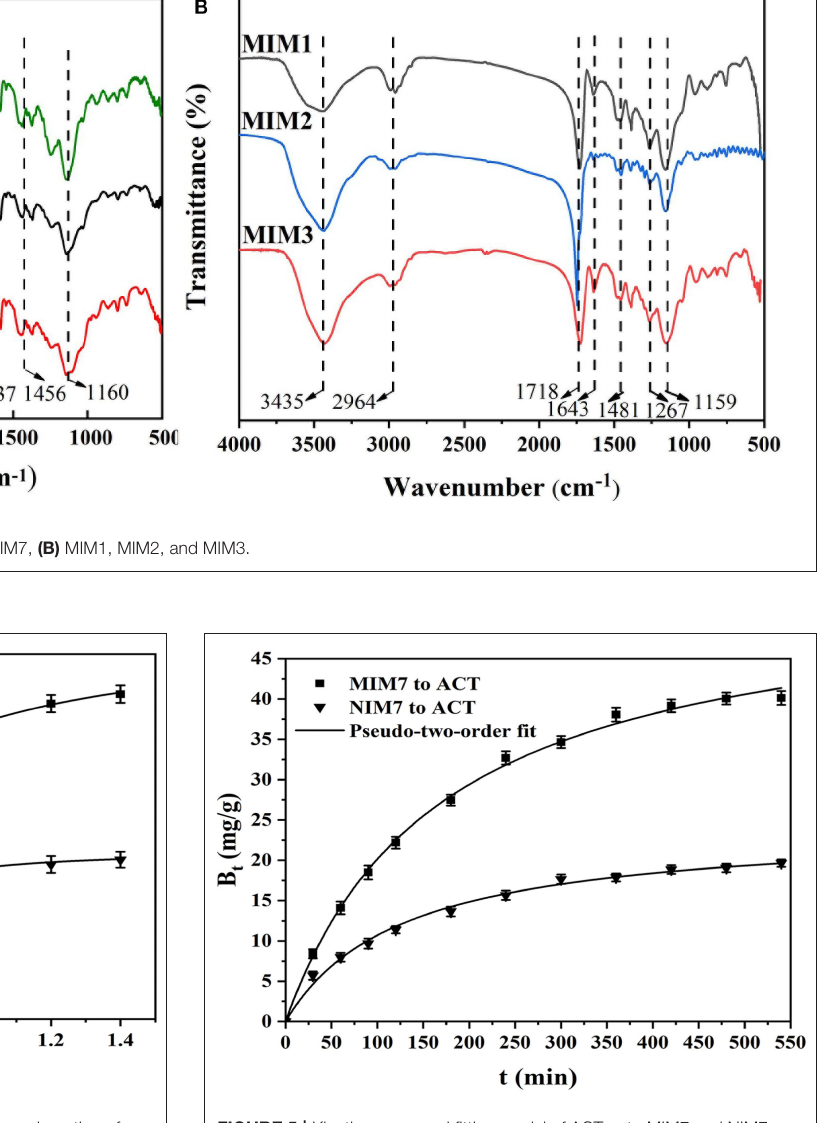
FIGURE 5 | Kinetic curves and fitting model of ACT onto MIM7 and